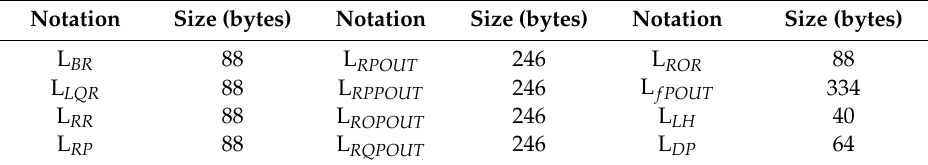
Table 1. Parameters and packet size.